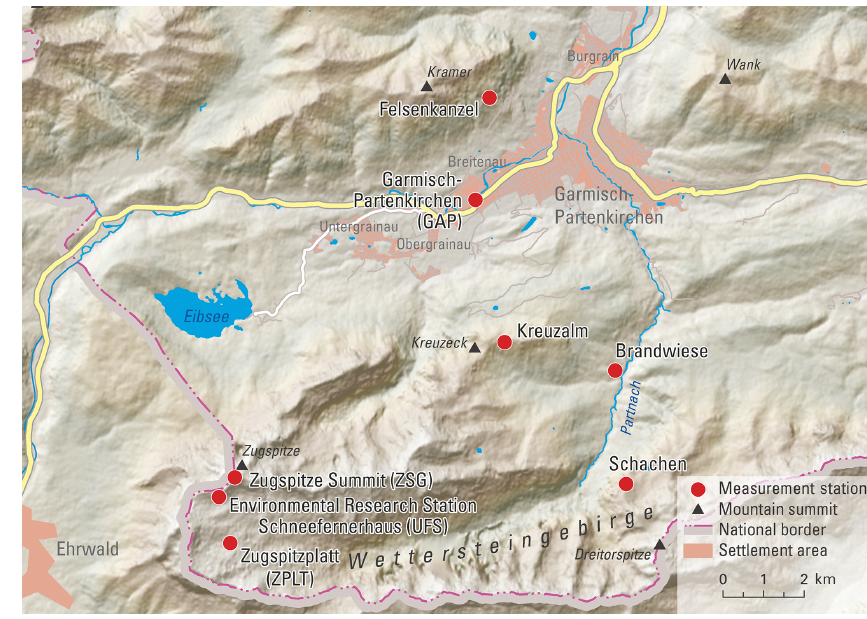
Figure 1. Location of the measurement sites in the surrounding of Zugspitze. North is at the